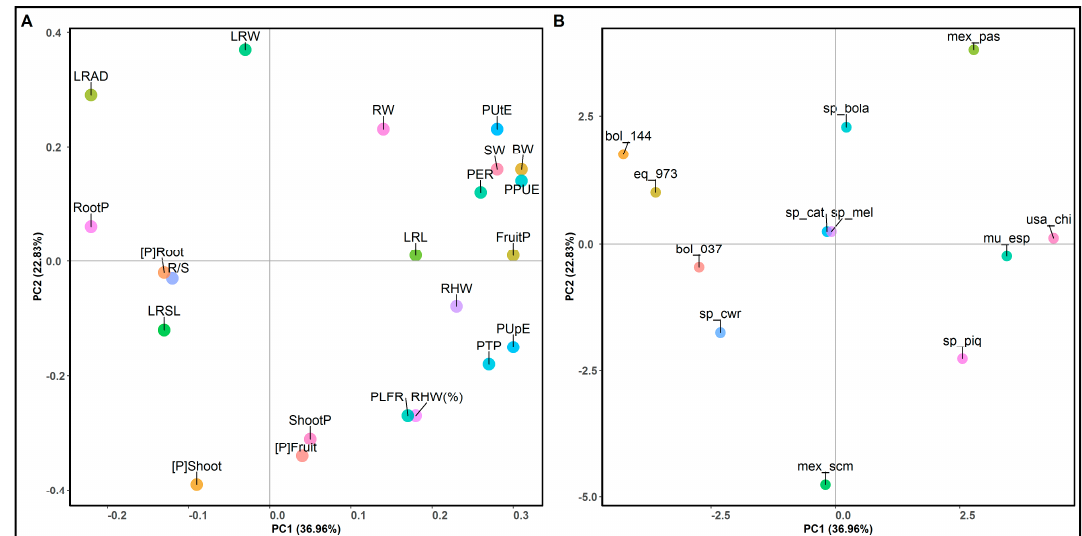
Figure 3. Principal Component Analysis (PCA) for the first two components based on trait differences between treatments for Trial 1. ( A ) Correlation between traits and the first two principal